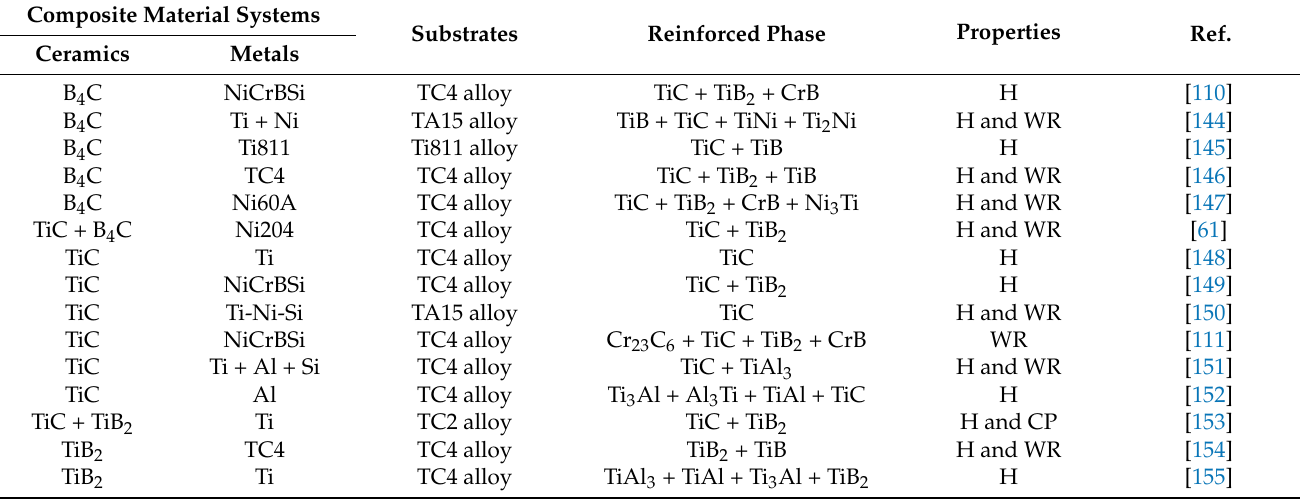
Table 4. The ceramic/metal composite powders for the surface modification of Ti-based alloys by LC. Composite Material